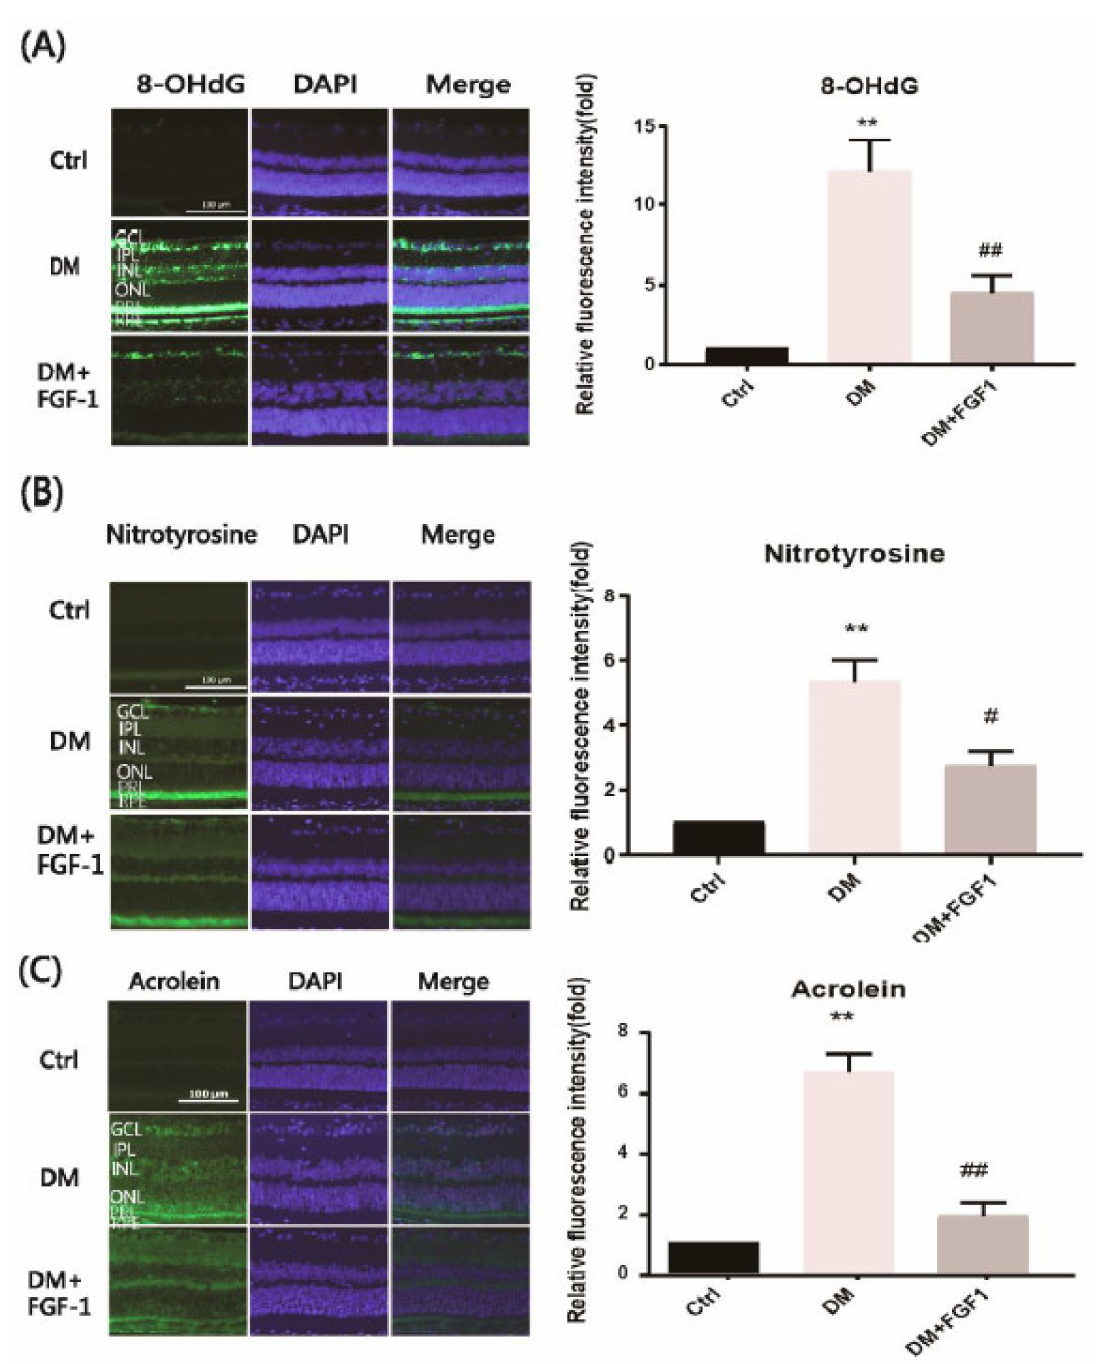
Figure 2. FGF-1 treatment reduced oxidative stress in the rat retinas. Retinal sections were collected from 12-week-old SD rats in each group. Immunofluorescence imaging of the expression of ( A ) 8-OHdG, ( B ) nitrotyrosine, and ( C ) acrolein in the retinal tissue ( n = 4 eyes in each group). Bar = 100 µ m. The relative densities of immunofluorescence were quantified using ImageJ software. Data are presented as mean ± standard deviation; ** p < 0.01 versus the control group; # p < 0.05, ## p < 0.01 versus the DM group. DAPI, 4 (cid:48) ,6-diamidino-2-phenylindole; Ctrl, control group; DM, STZ-induced diabetic rat group; DM + FGF-1, fibroblast growth factor type 1 treatment